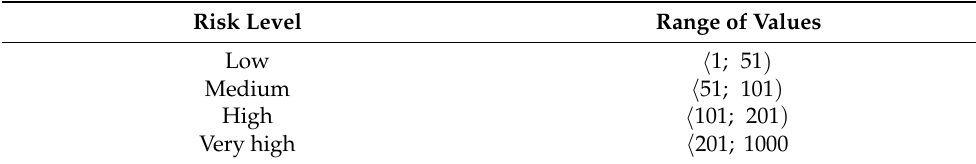
Table 9. RQE risk level classification. Own study based on